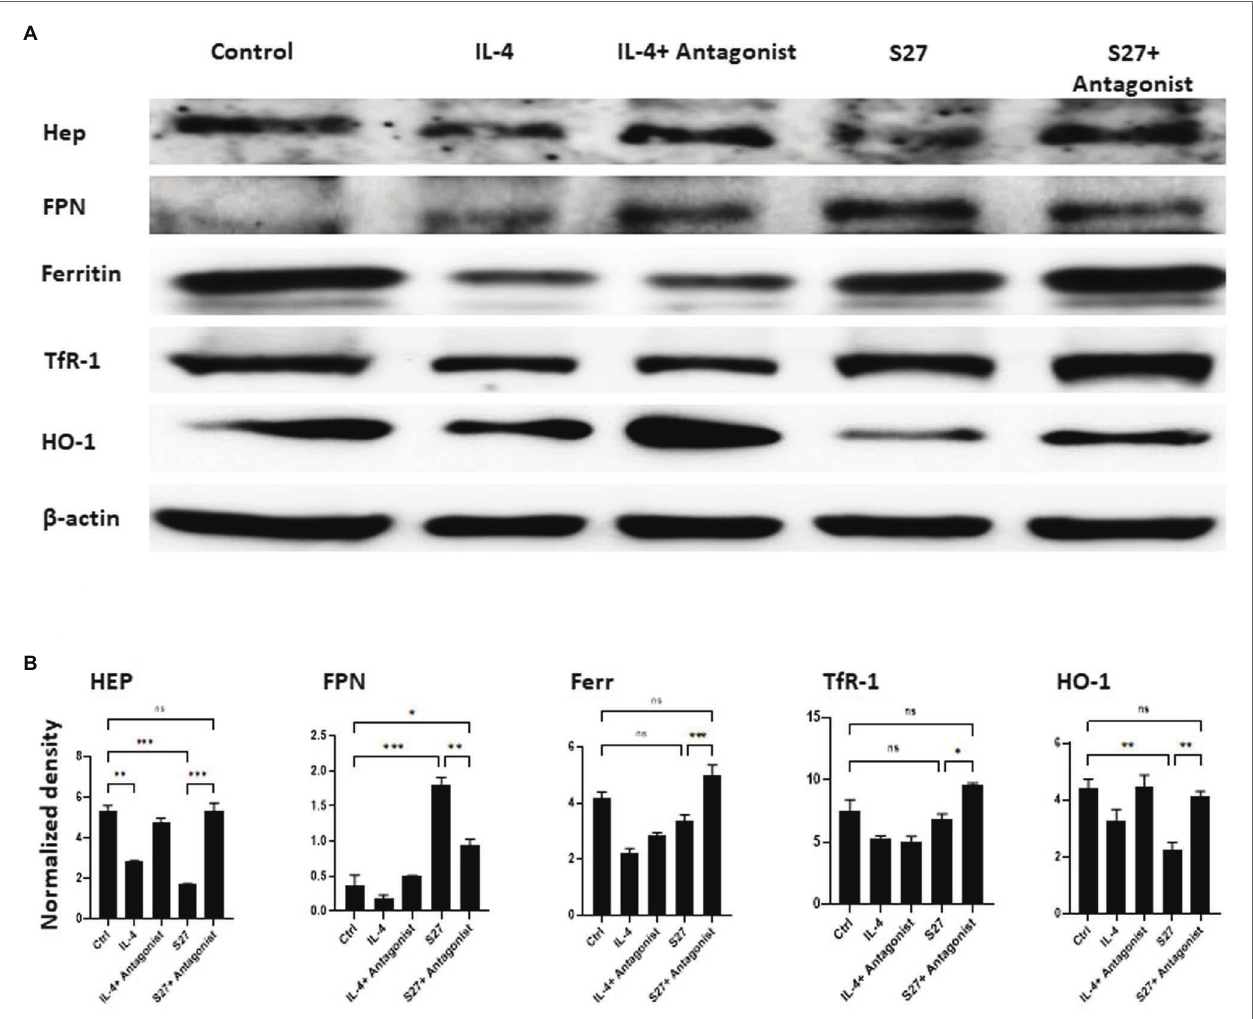
FIGURE 10 | Western blot analysis of the expression of Hep, FPN, Ferritin, TfR-1, and HO-1 in PBMMs cells treated with S27 alone or in the presence of STAT-6 antagonist. (A) Cell lysates were prepared from PBMMs treated with IL-4 at 15 ng/ml and in addition to STAT-6 antagonist at 1 μ M and S27 at 10 ng/ml/STAT-6 antagonist at 1 μ M. As they were cultured for 8 days. The results shown are representative of three experiments. (B) The band intensity was measured by densitometry using the Image J software. The results were analyzed using one-way ANOVA and presented as means ± SEM of three independent experiments. * p < 0.05, ** p < 0.01 and *** p < 0.001, which is significantly different from other